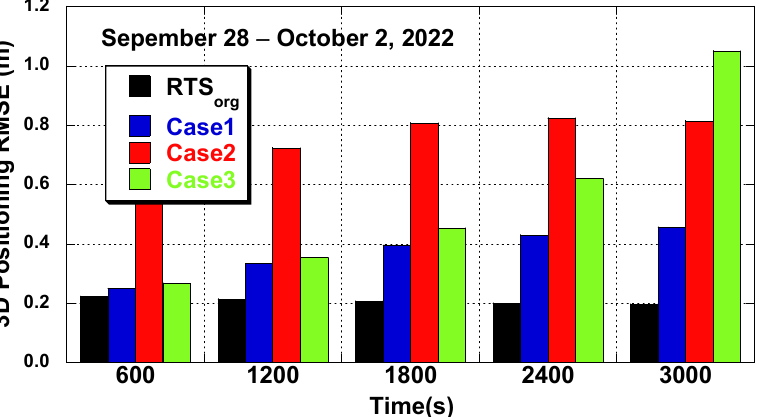
Figure 12. Positioning error at different prediction intervals (ONS1, 28 September–2 October 2022).